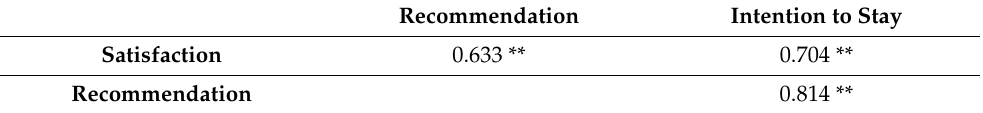
Table 17. Correlations between Satisfaction, Recommendation and Intention to stay.